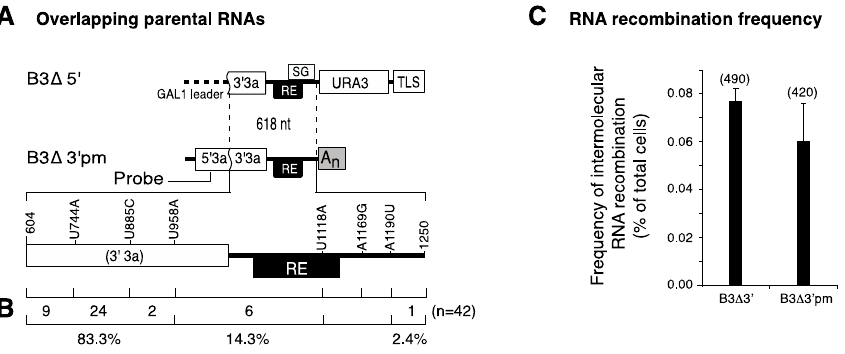
Figure 1. Distribution of crossover sites after one yeast generation in brome mosaic virus (BMV) RNA3. Single lines represent non-coding regions, and labeled boxes represent 3a, URA3, the template recruitment element (RE), the subgenomic RNA4 promoter (SG), and the 3 ′ tRNA-like sequence (TLS). ( A ) Recombination partners B3 ∆ 5 (cid:48) and B3 ∆ 3 (cid:48) pm are non-replicatable, overlapping (~618 nt)